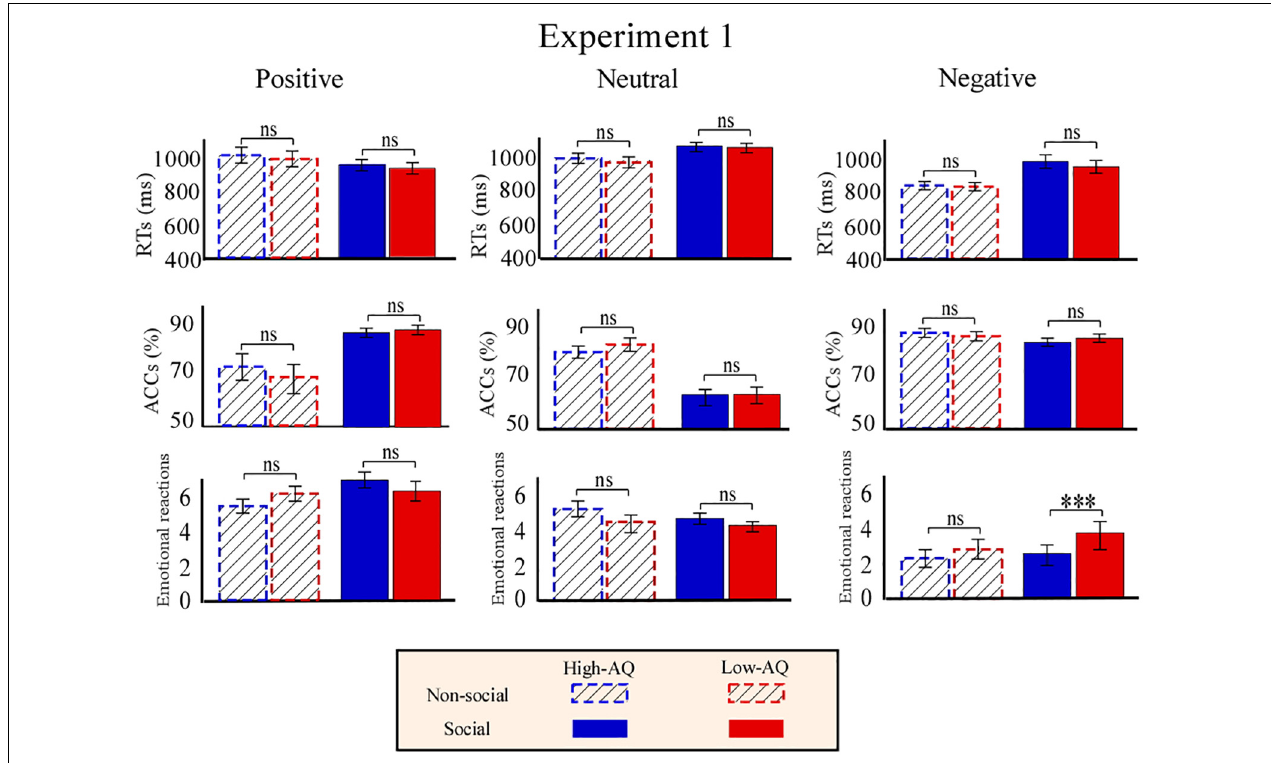
FIGURE 3 | Behavioral results from Experiment 1. Bar charts show responses of High-AQ (blue) and Low-AQ (red) groups to positive (left column) , neutral (middle column) , and negative (right column) pictures with social (solid bar) or non-social (dotted bar) dimensions. Data of RTs, ACCs, and emotional reactions are shown in the top, middle, and bottom panels. Data in the bar charts are expressed as Mean ± SEM. ns p > 0.05, * p < 0.05, ** p < 0.01, *** p <